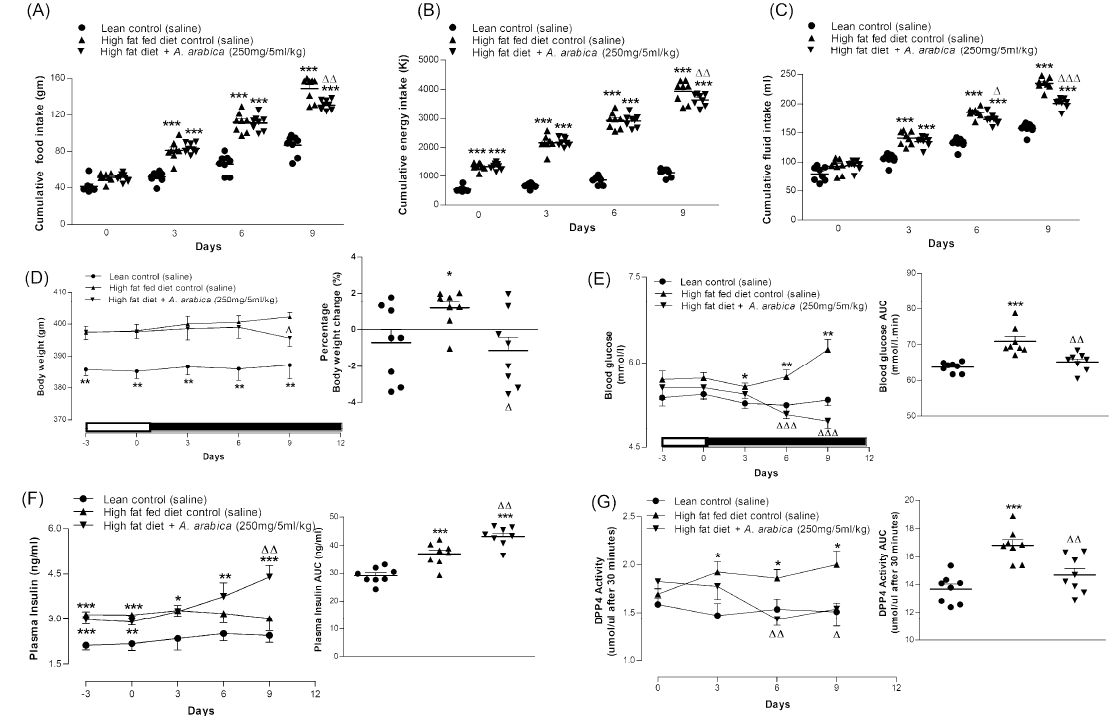
Figure 4. Effects of 9-day, twice-daily oral administration of hot-water extract of A. arabica bark on ( A ) food intake, ( B ) energy intake, ( C ) fluid intake, ( D ) body weight, ( E ) blood glucose, ( F ) plasma insulin and ( G ) DPP-IV enzyme activity in high-fat-fed rats. Parameters were measured prior to and after oral administration of A. arabica bark (250 mg/5 mL/kg, body weight) twice daily. Values are the mean ± SEM for n = 8 rats. * p < 0.05, ** p < 0.01 and *** p < 0.001 compared to lean control. ∆ p < 0.05, ∆∆ p < 0.01 and ∆∆∆ p < 0.001 compared to high-fat-fed control at corresponding time